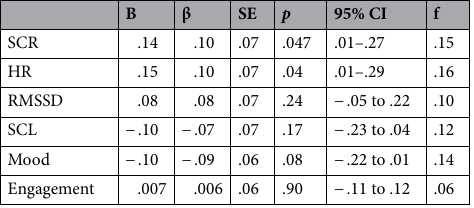
Table 1. Outcomes of the multi-level model including standardized and unstandardized betas and Cohen’s f effect